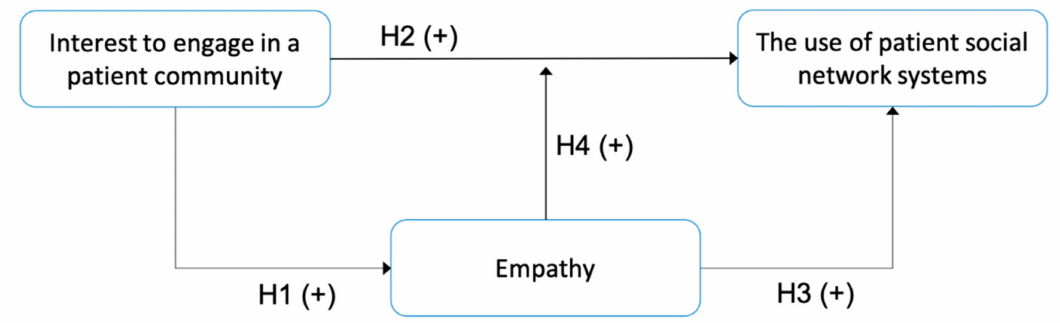
Figure 1. The research model based on the integration of affective events theory (AET) and self-determination theory